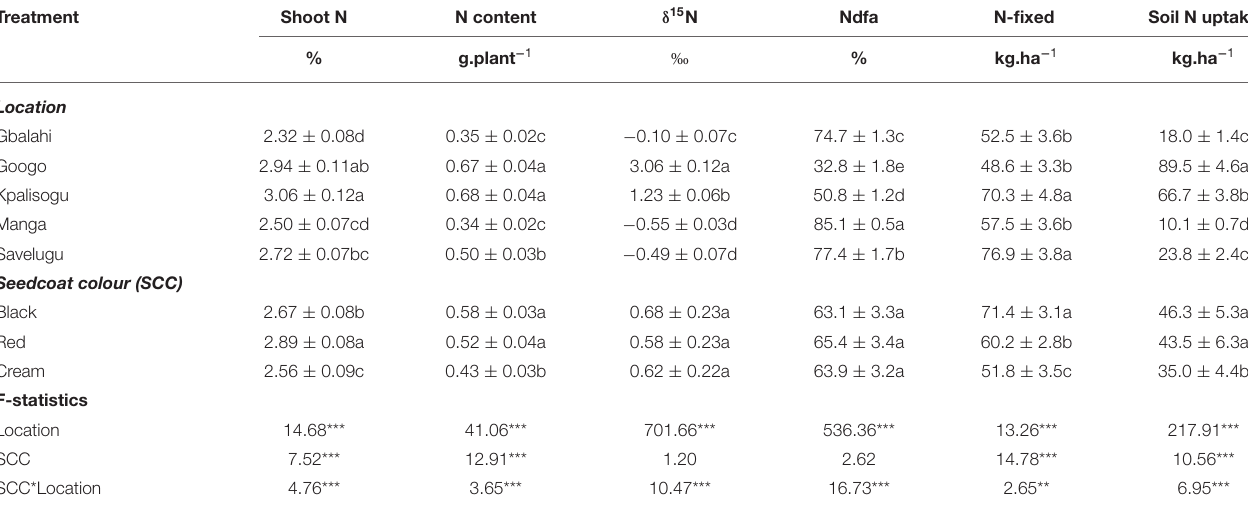
TABLE 7 | Effects of seedcoat colour (SCC) and environment on the N nutrition of Bambara groundnut landrace sampled at flowering (56 DAP). Treatment Shoot N N content δ 15 N Ndfa